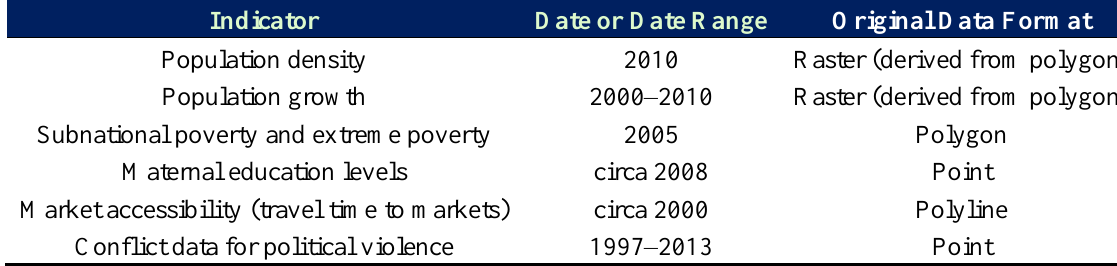
Table 2. Indicators used in the social vulnerability index of the coastal